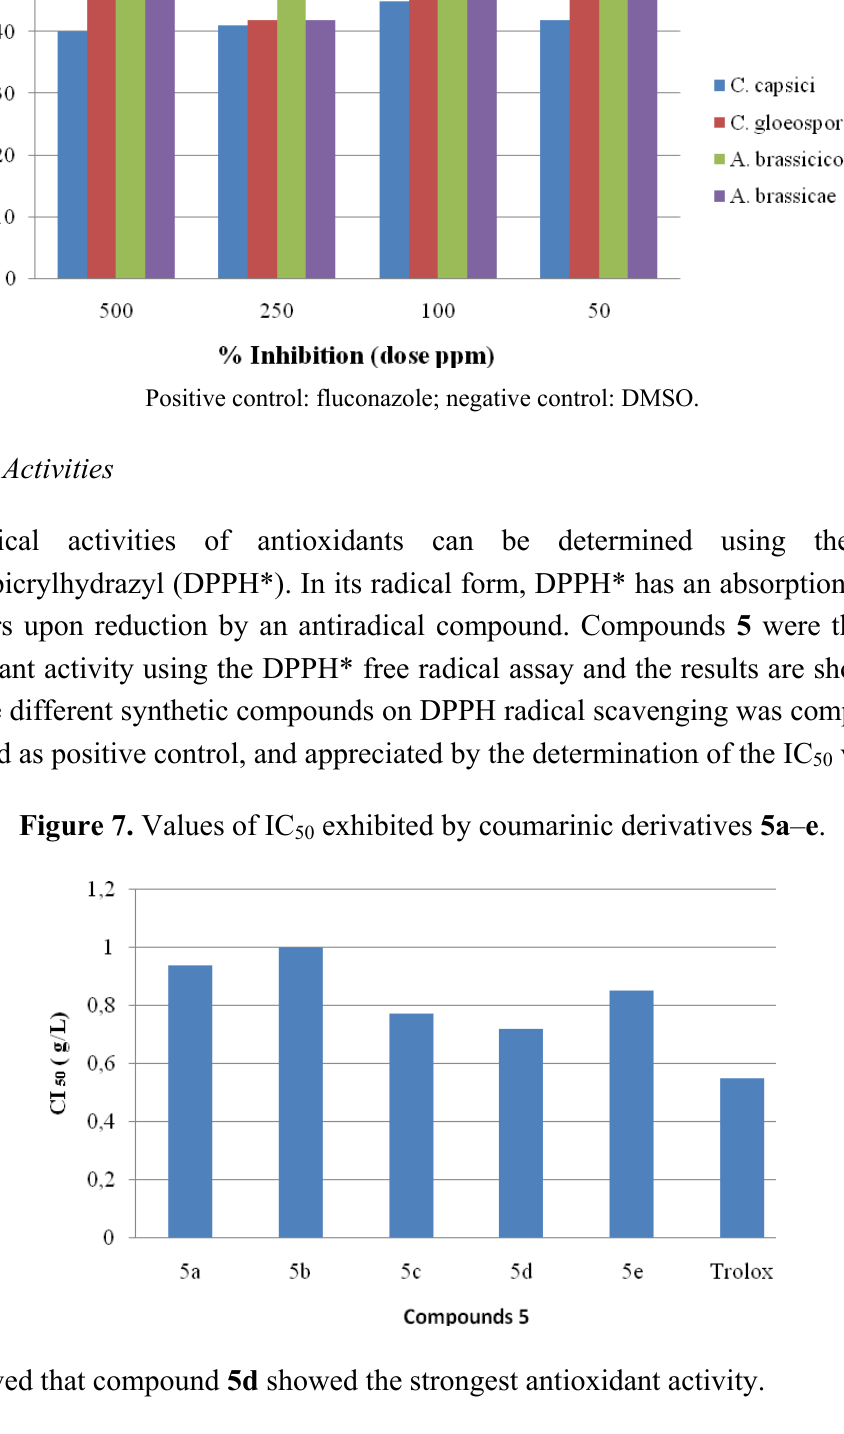
Figure 6. Antifungal results for compound 5e .